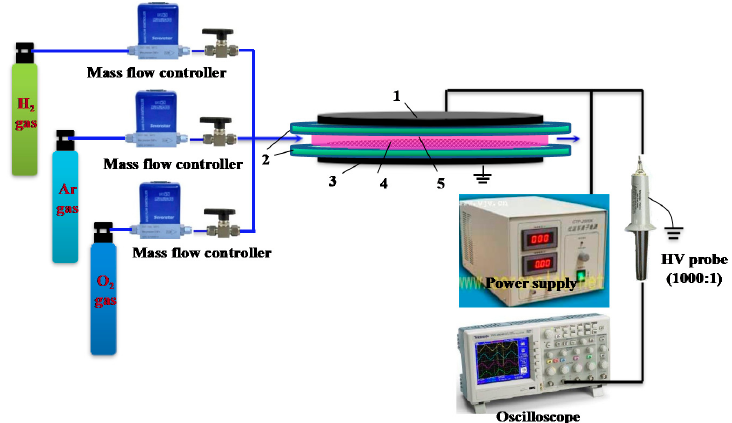
Figure 1. Schematic of the atmospheric-pressure (AP) dielectric barrier discharge (DBD) cold plasma device for activating Au/P25 catalysts. 1-discharge electrode, 2-quartz reactor, 3-ground electrode, 4-sample, 5-cold plasma.